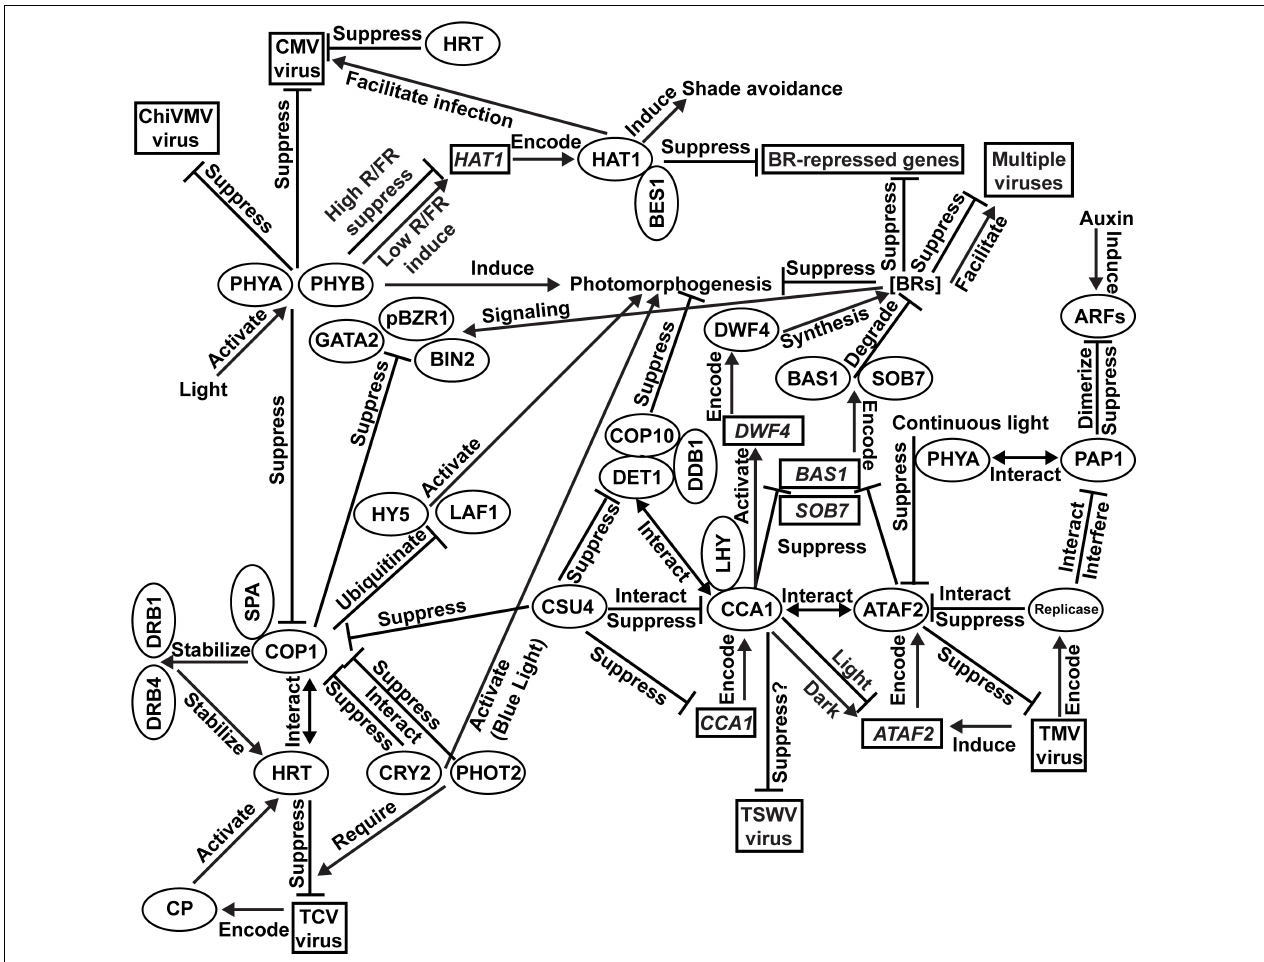
FIGURE 1 | Integration of photomorphogenesis and virus resistance. Results of PHYA/PHYB-mediated resistance to Cucumber mosaic virus (CMV) and Chilli veinal mottle virus (ChiVMV) come from Nicotiana tabacum . All other findings are based on investigations using Arabidopsis